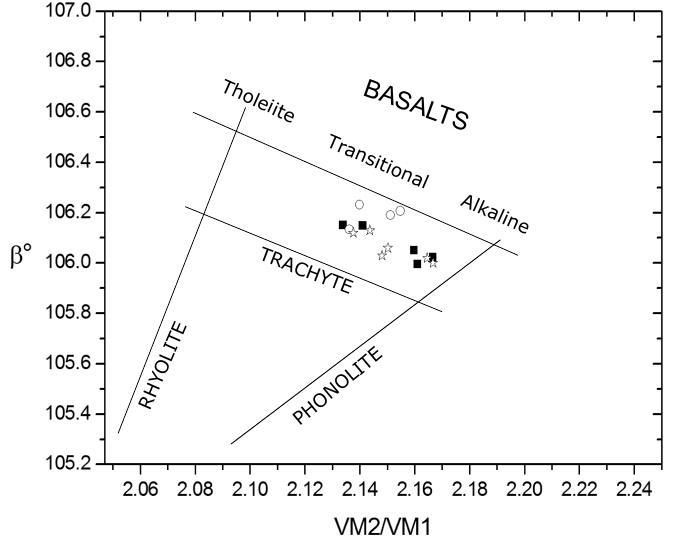
Figure 7. Monoclinic ( β ) angle vs polyhedral M2 and M1 ratio. Symbols: full squares: clinopyroxenes from host trachytes; open circle: clinopyroxenes from enclaves; and star: clinopyroxene from [37]. Tholeiitic, transitional and alkaline field are from